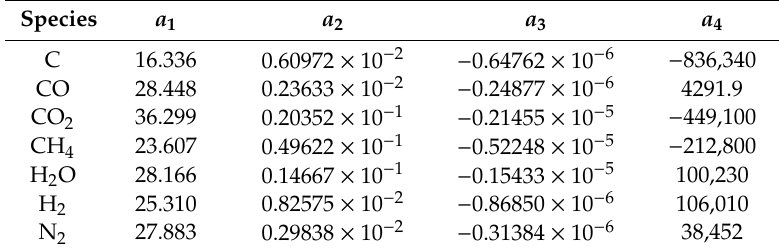
Table 4. Coe ffi cients for the specific heat calculation